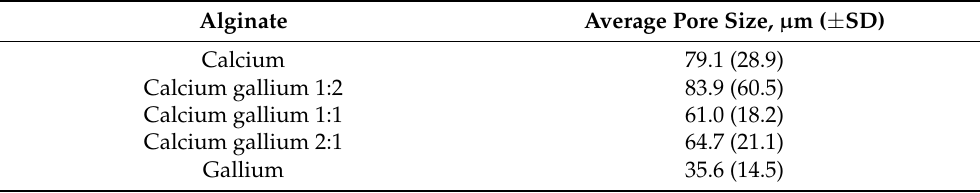
Table 1. Pore size and alginate strand angle measurements for various alginate